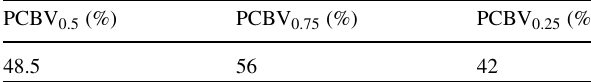
Table 8 PCBV quantiles for median estimation